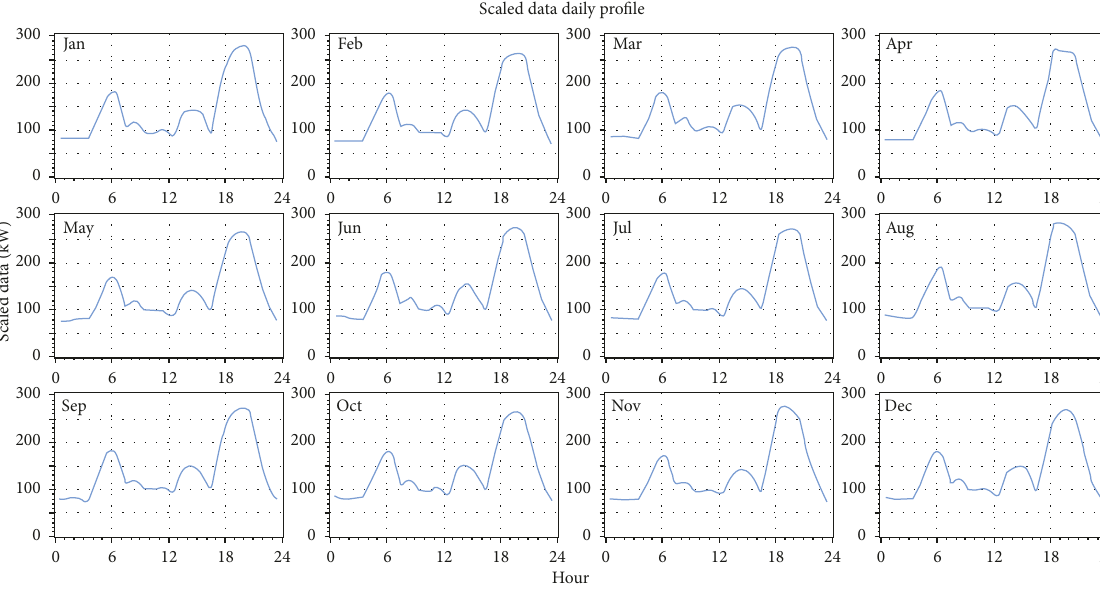
Figure 10: Hourly load profile for each month in a year. Table 2: Testing results of Ancol Bligo irrigation